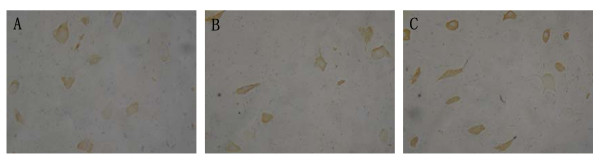
Effects of TMP on Bcl-2 expression in spinal cord at the 48th hour reperfusion. Immunohistochemical photomicrographs (magnification × 400) of anterior horn tissue stained for Bcl-2 protein in sham group (A), control group (B) and TMP group (C). Immunostaining was performed using a specific anti- Bcl-2 antibody and developed with stable DAB. The positive staining of Bcl-2 is presented by a brown color of cytoplasm. Figures are representative of 3 separate experiments with similar results.